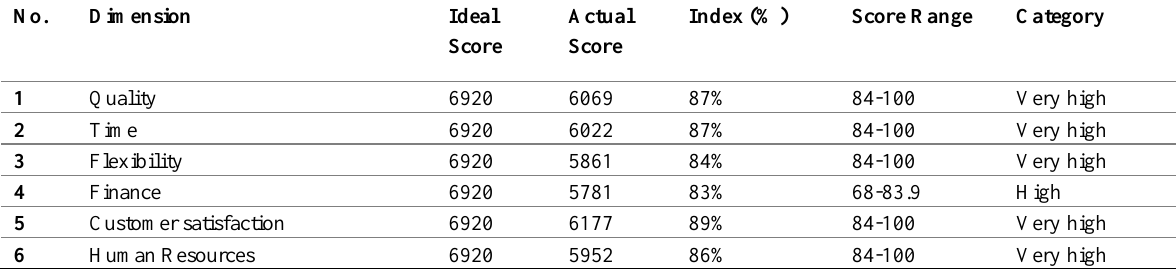
Table 12: Performance